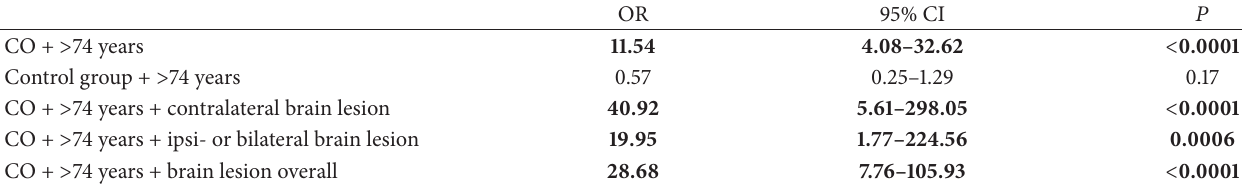
Table 4: Multivariate analysis of the role of age > 74 years and brain lesion by side in 1639 primary carotid